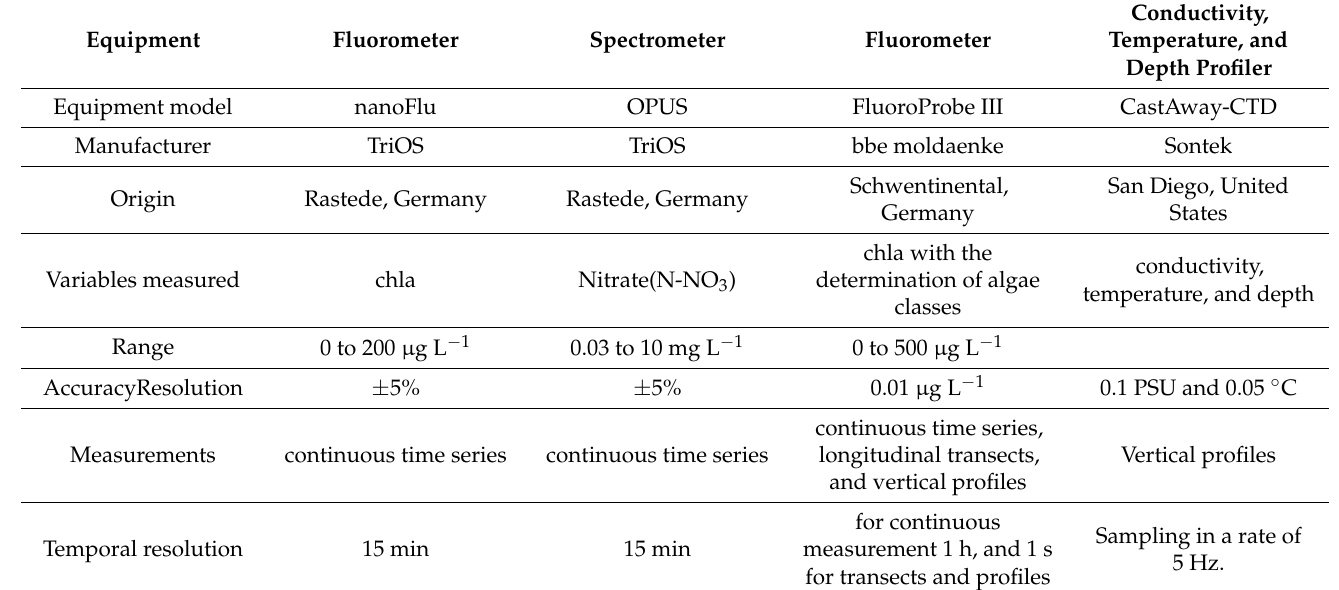
Table 1. Sensor’s specification regarding variables measured, type of measurement, range, accuracy, and temporal